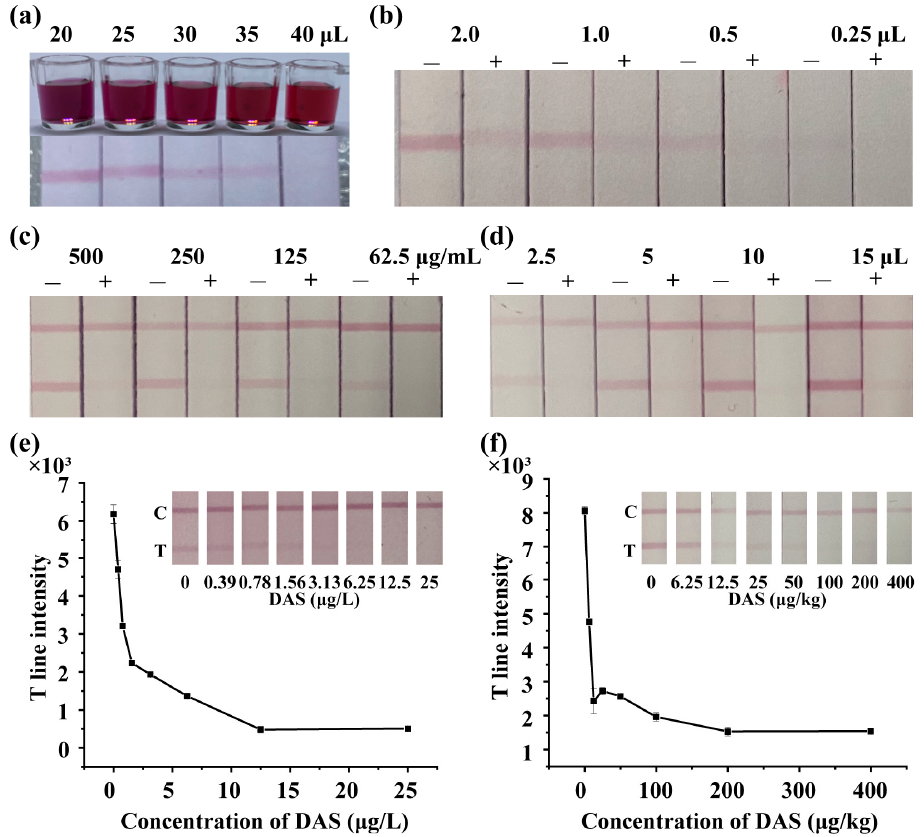
Figure 3. Optimization and detection of the LFIA strips. Optimization of ( a ) the volume of K 2 CO 3 , ( b ) amount of mAb, ( c ) concentration of coating antigen and ( d ) amount of mAb-labelled AuNPs with a negative sample (0 μ g/L DAS) and a positive sample (25 μ g/L DAS). “ − ” means negative, “+” means positive. Various concentrations of DAS in ( e ) PBS buffer and ( f ) rice samples have been detected.